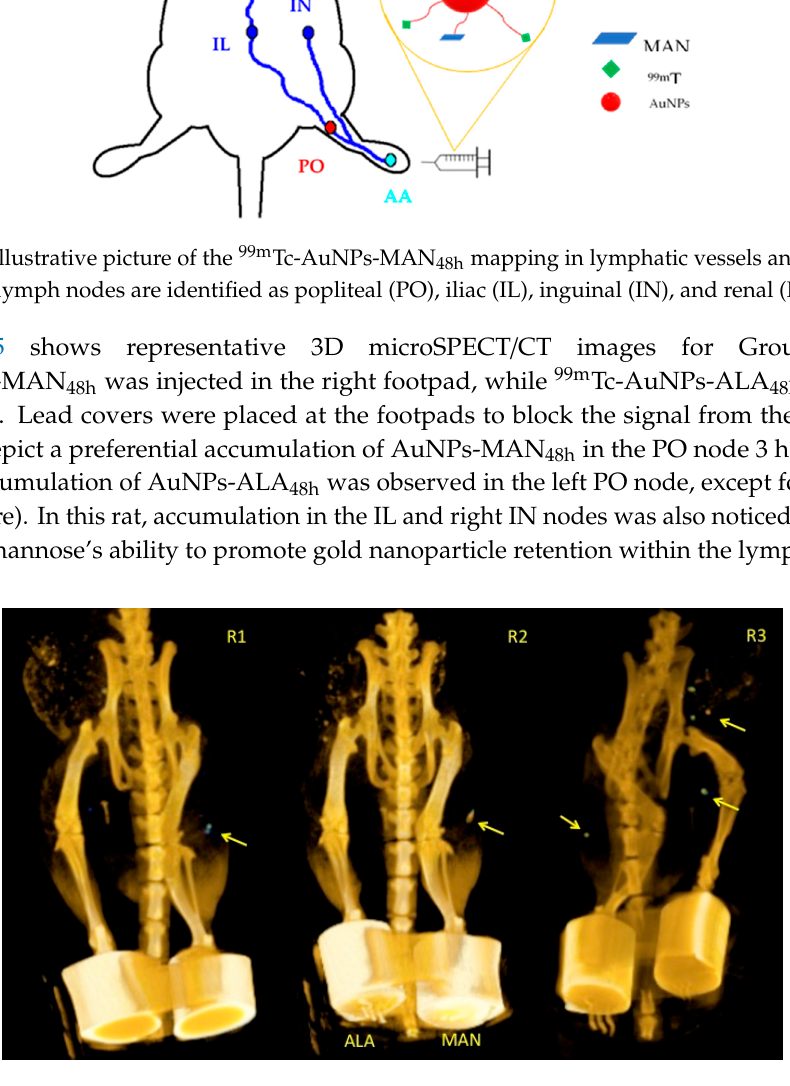
Table 3. Average percentage of injected dose at injection site and popliteal nodes.